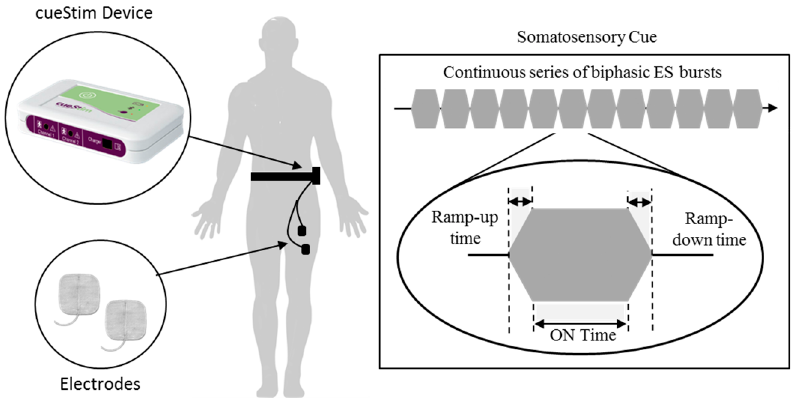
Figure 15. Illustration of a user wearing the cueStim continuous somatosensory cueing device. The device was worn on the waist and delivered a continuous series of biphasic electrical stimulation (ES) bursts through the use of 50 × 50 mm 2 skin surface electrodes placed over the skin surface of the hamstring or quadriceps muscle of the body side most affected by the user.